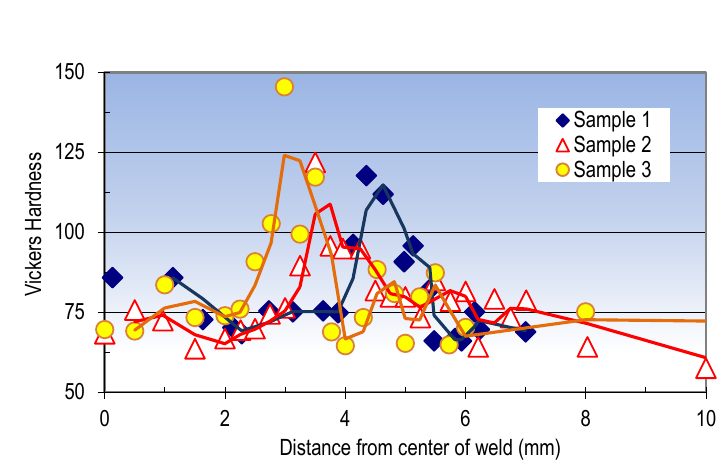
Figure 11: Vicker microhardness of the matrix across the weld of three specimens. Each line is the moving average of two data points on a weld zone. Microhardness test at 25 gf, 10 s. Preheating and GTAW at 85 A AC, 260 mm/min welding